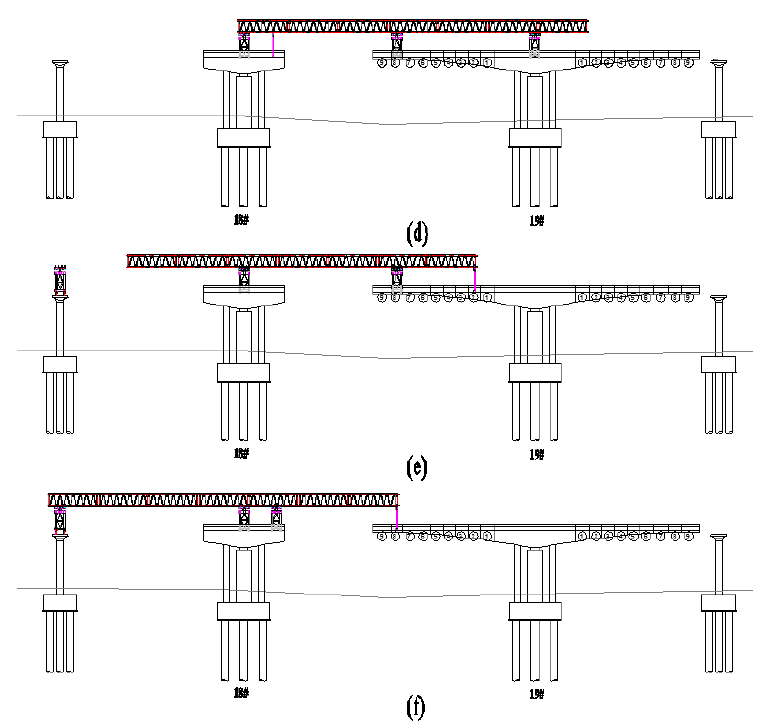
Figure 7. Flow chart of the hole passing.